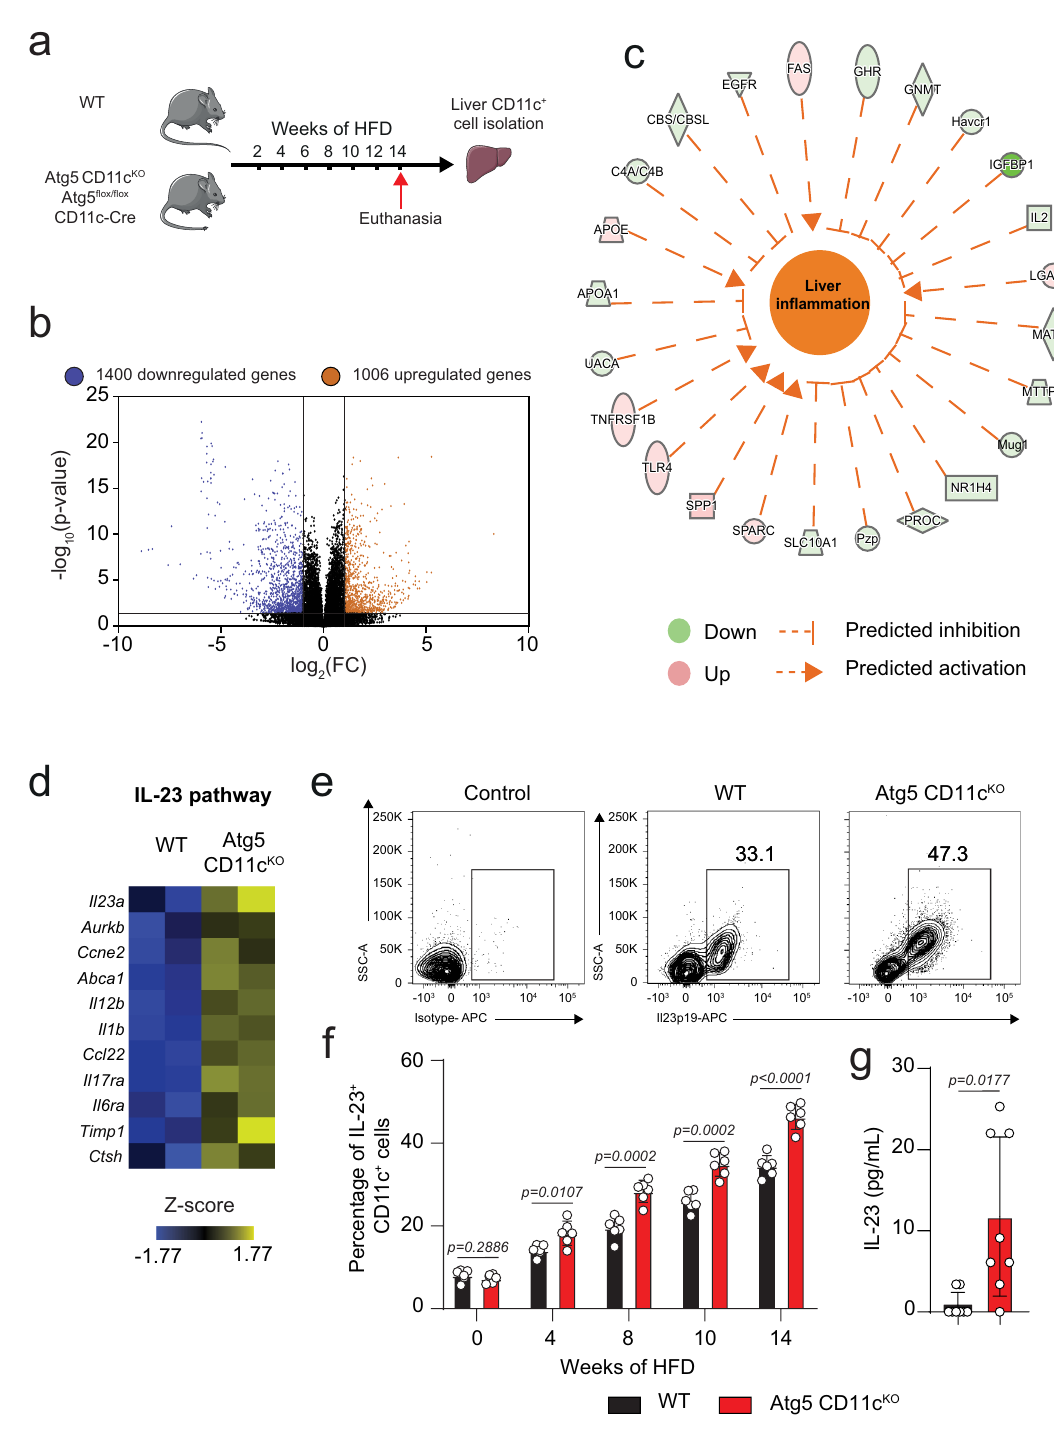
Fig. 5 Atg5 deletion in CD11c + cells increases IL-23 induction. a WT and Atg5 CD11c KO mice were fed HFD for 14 weeks according to the scheme, n = 6. After 14 weeks of HFD, hepatic CD11c + cells were isolated. b Volcano plot comparison of whole transcriptome gene expression of sorted hepatic WT and Atg5 CD11c KO cells from mice fed HFD for 14 weeks, n = 6. Differentially expressed genes ( p -value < 0.05), with changes of at least 2-fold change (FC) are shown in orange (upregulated) or blue (downregulated). c Network analysis of upregulated (red) and downregulated (green) genes overall signi fi cantly predicted to induce liver in fl ammation. d Heat plot of differentially expressed genes related to IL-23 pathway. e Representative fl ow cytometric plots of IL-23 expression in hepatic CD11c + cells in WT and Atg5 CD11c KO mice after 14 weeks of HFD. f Percentage of hepatic IL-23 + CD11c + cells after 0, 4, 8, 10, and 14 weeks of HFD, n = 5 mice. g Serum IL-23 levels in WT and Atg5 CD11c KO after 14 weeks of HFD, n = 8 mice. Error bars are the mean± SD, two-tailed Student ’ s t test. Experiments were performed three times. Source data are provided as a Source Data fi le. Mouse image provided with permission from Servier Medical